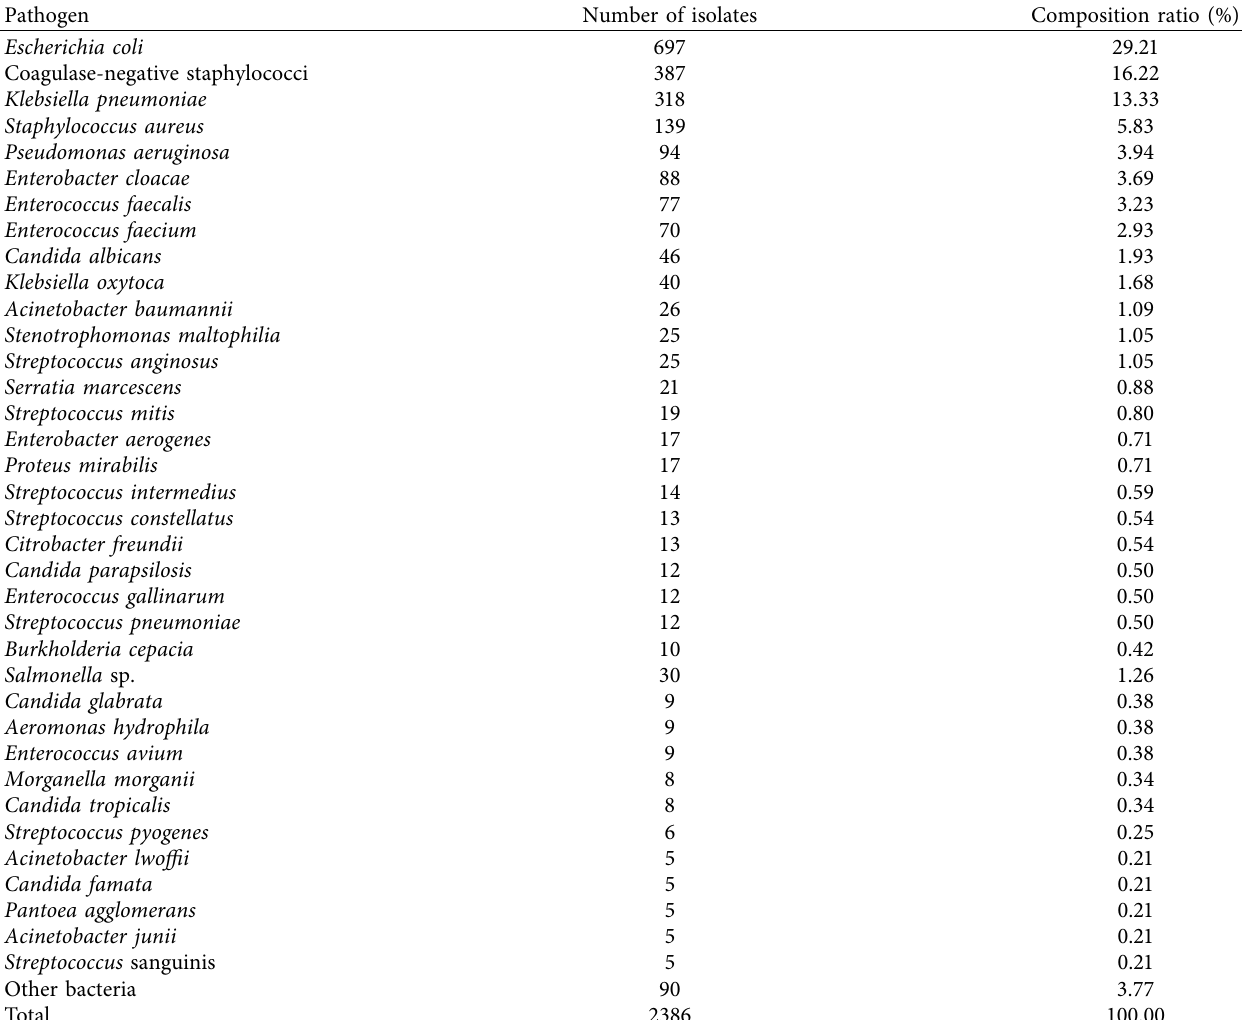
Table 1: The ratio of pathogens in cancer patients complicated with